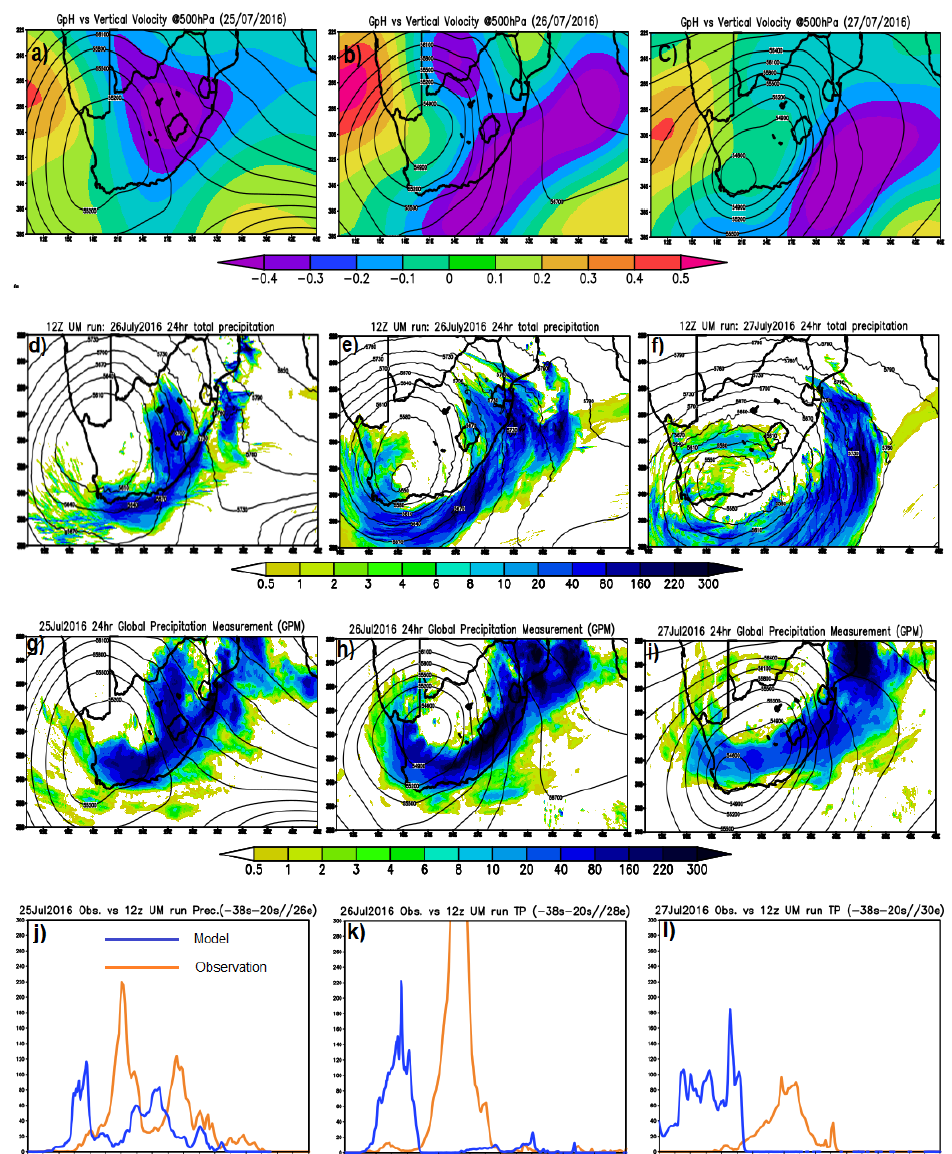
Figure 4. Geopotential height at 500 hPa (thin black contours) together vertical velocity (shaded) ( a , b , c ), at 12Z UM 24 h on the 25th, 26th and 27th July 2016. The second-row panels ( d , e , f ) show UM total precipitation (shaded) and geopotential height at 500 hPa, at the same as time as in the top panels. The third-row panels ( g , h , i ) show the total precipitation and geopotential height at 500 hPa for the ERA Interim for the same time as in ( a , b , c ). The bottom panels ( j,k,l ) show model (blue curve) and observation (orange curve) diurnal cycle precipitation for the same times as in ( a , b , c ).